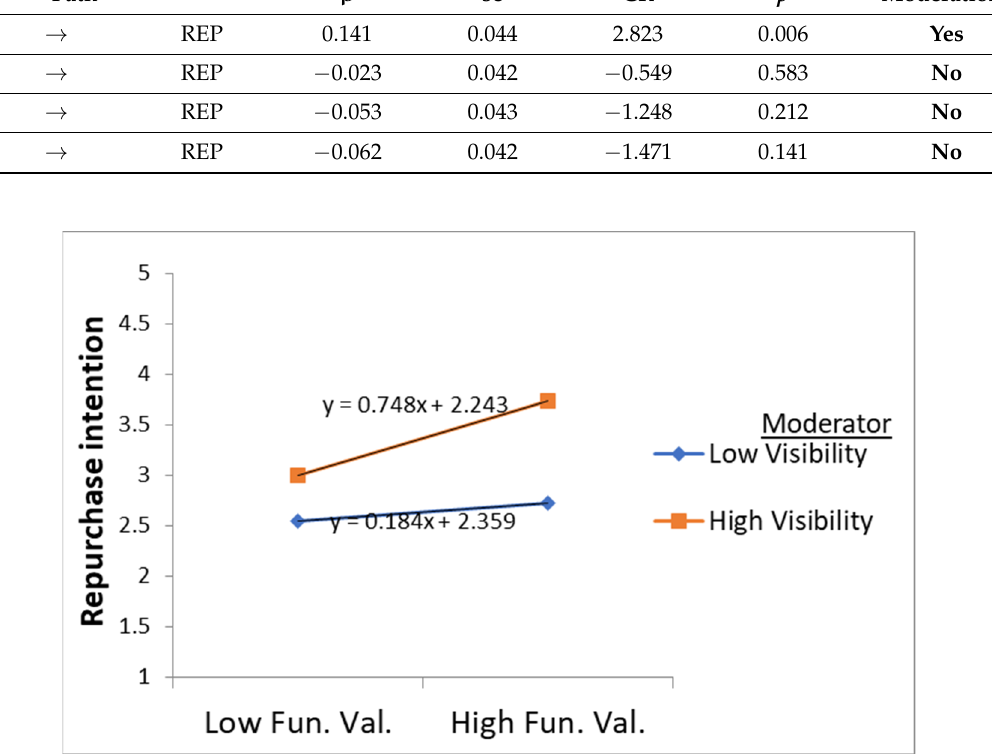
Table 6. Results of Moderation Analysis with Visibility as a moderator.